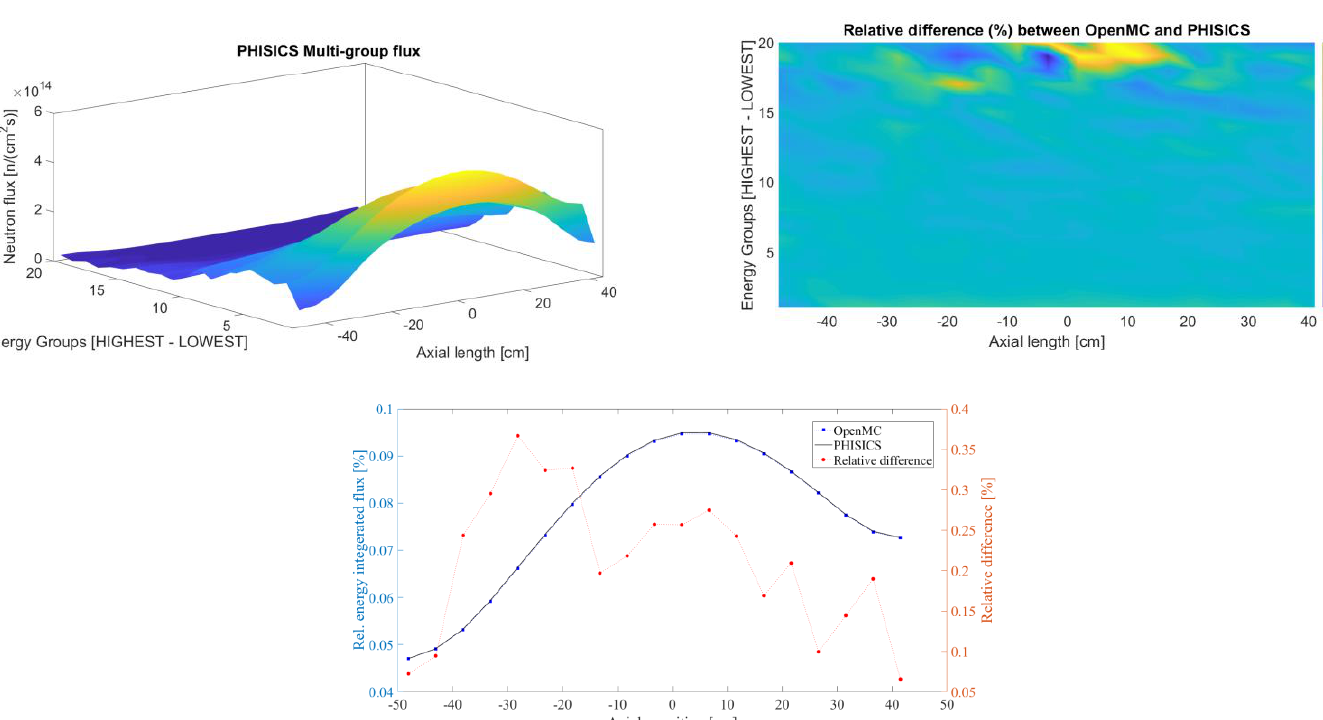
Figure 7. PHISICS vs. OpenMC MGMC benchmark for the central assembly (Fast IPS)